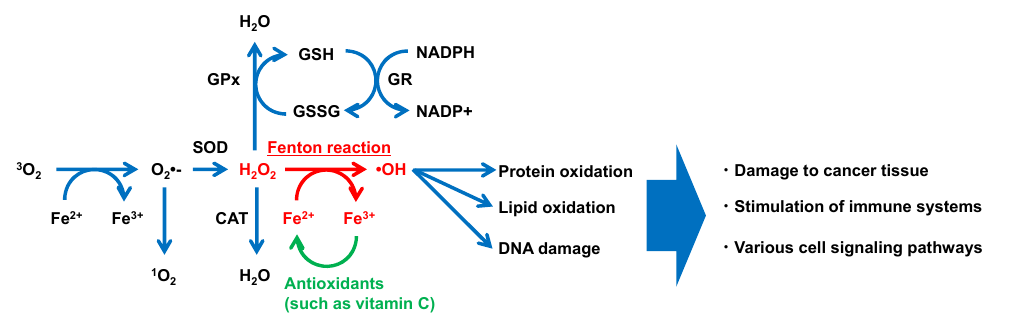
Figure 3. Typical model of reactive oxygen species generation via the Fenton reaction in a biological environment. CAT, catalase; GPx, glutathione peroxidase; GR, glutathione reductase; GSH, reduced glutathione; GSSG, oxidized glutathione; NADPH, reduced form of nicotinamide adenine dinucleotide phosphate; NADP + , oxidized form of nicotinamide adenine dinucleotide phosphate; SOD, superoxide dismutase (modified with permission from [61] under the Creative Commons CC BY 3.0 license, https://creativecommons.org/licenses/by/3.0/ (accessed on 28 July 2022)) .